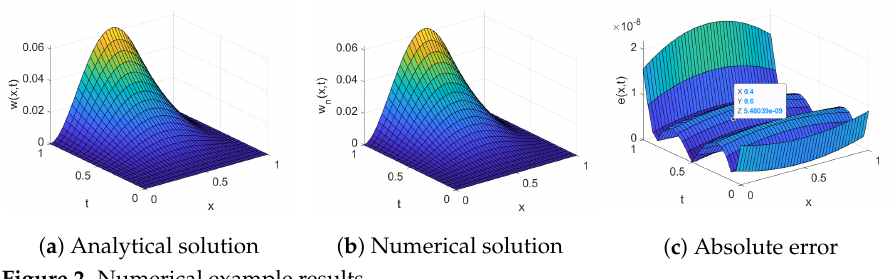
Figure 2. Numerical example results.